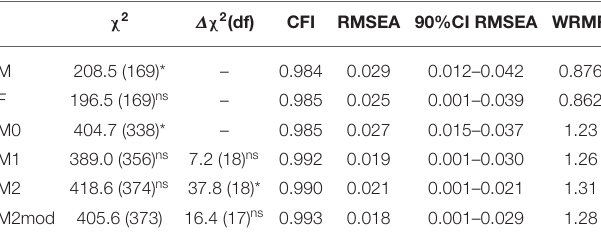
TABLE 3 | Chi-square and goodness-of-fit indices for the DIF